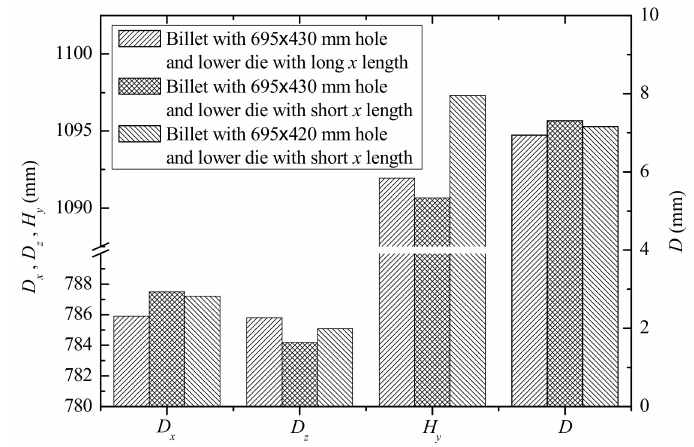
Figure 16. Size of branch flanged by di ff erent elliptic pre-holes and geometries of lower